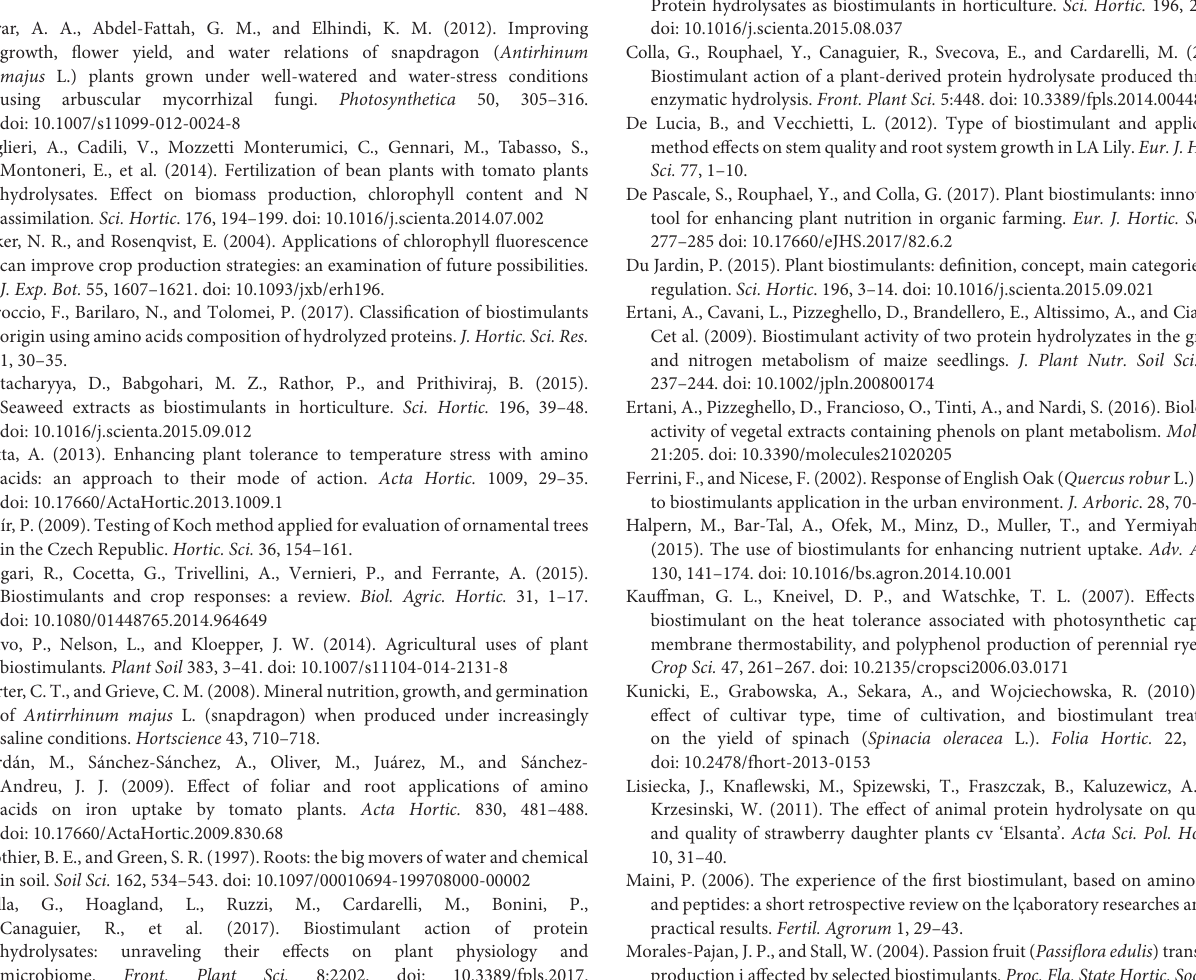
Table S4 | The effects of the interaction between biostimulant application methods and cultivar on snapdragon plants characteristics: leaf (n/plant),